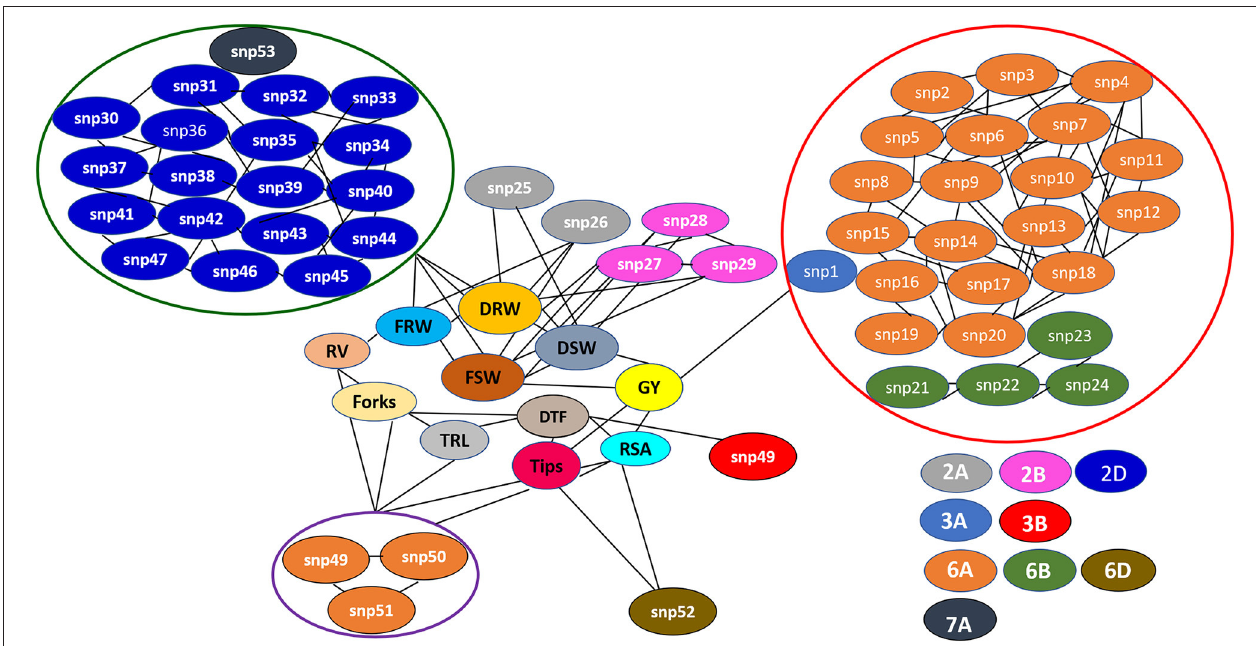
FIGURE 6 | The single nucleotide polymorphism (SNP) network indicating consistent significant marker-trait interactions across seasons and treatments (N0, N60, and N120). snp1: AX-95136668; snp2: AX-94415776; snp3: AX-94978974; snp4: AX-94737868; snp5: AX-95210745; snp6: AX-95631197; snp7: AX-95011132; snp8: AX-95255669; snp9: AX-95219967; snp10: AX-95070275; snp11: AX-94970334; snp12: AX-94894393; snp13: AX-95249202; snp14: AX-94553503; snp15: AX-94696366; snp16: AX-94386201; snp17: AX-94835065; snp18: AX-94914391; snp19: AX-94606161; snp20: AX-95072891; snp21: AX-94511241;